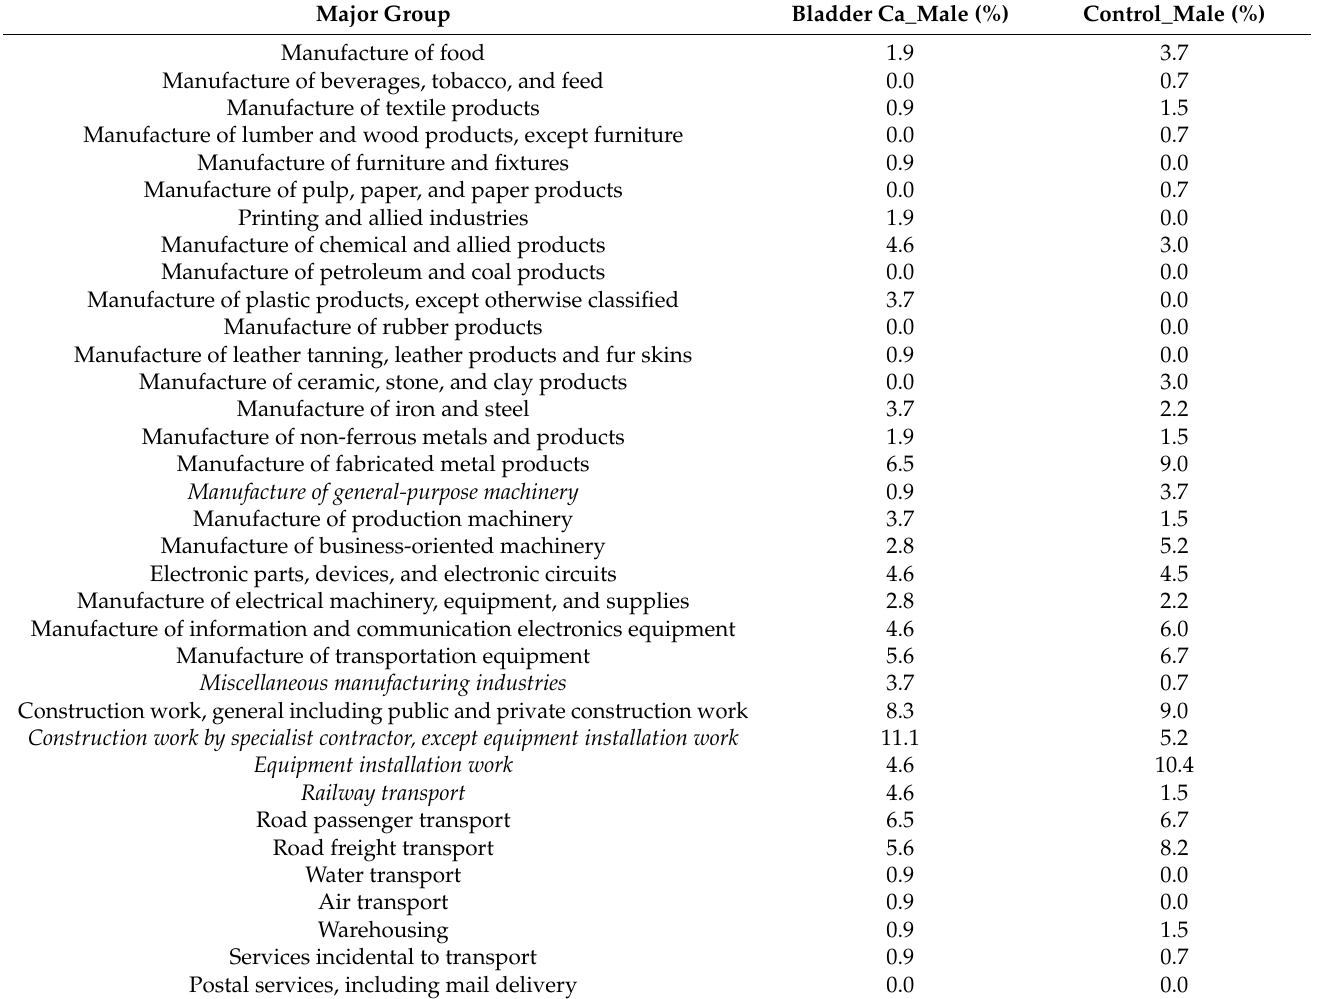
Table 5. Distribution of industrial classification major groups in divisions D, E, and H in males. Major